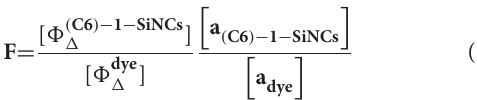
conjugate with the 317.5 nm laser results in 1 O 2 phosphorescence with 8 1 = 20 ± 5%. The enhancement factor (F) of 1 O 2 oxygen generation with UV light (317.5 nm) for C6-1-SiNCs vs. dye-1 can be determined using Equation